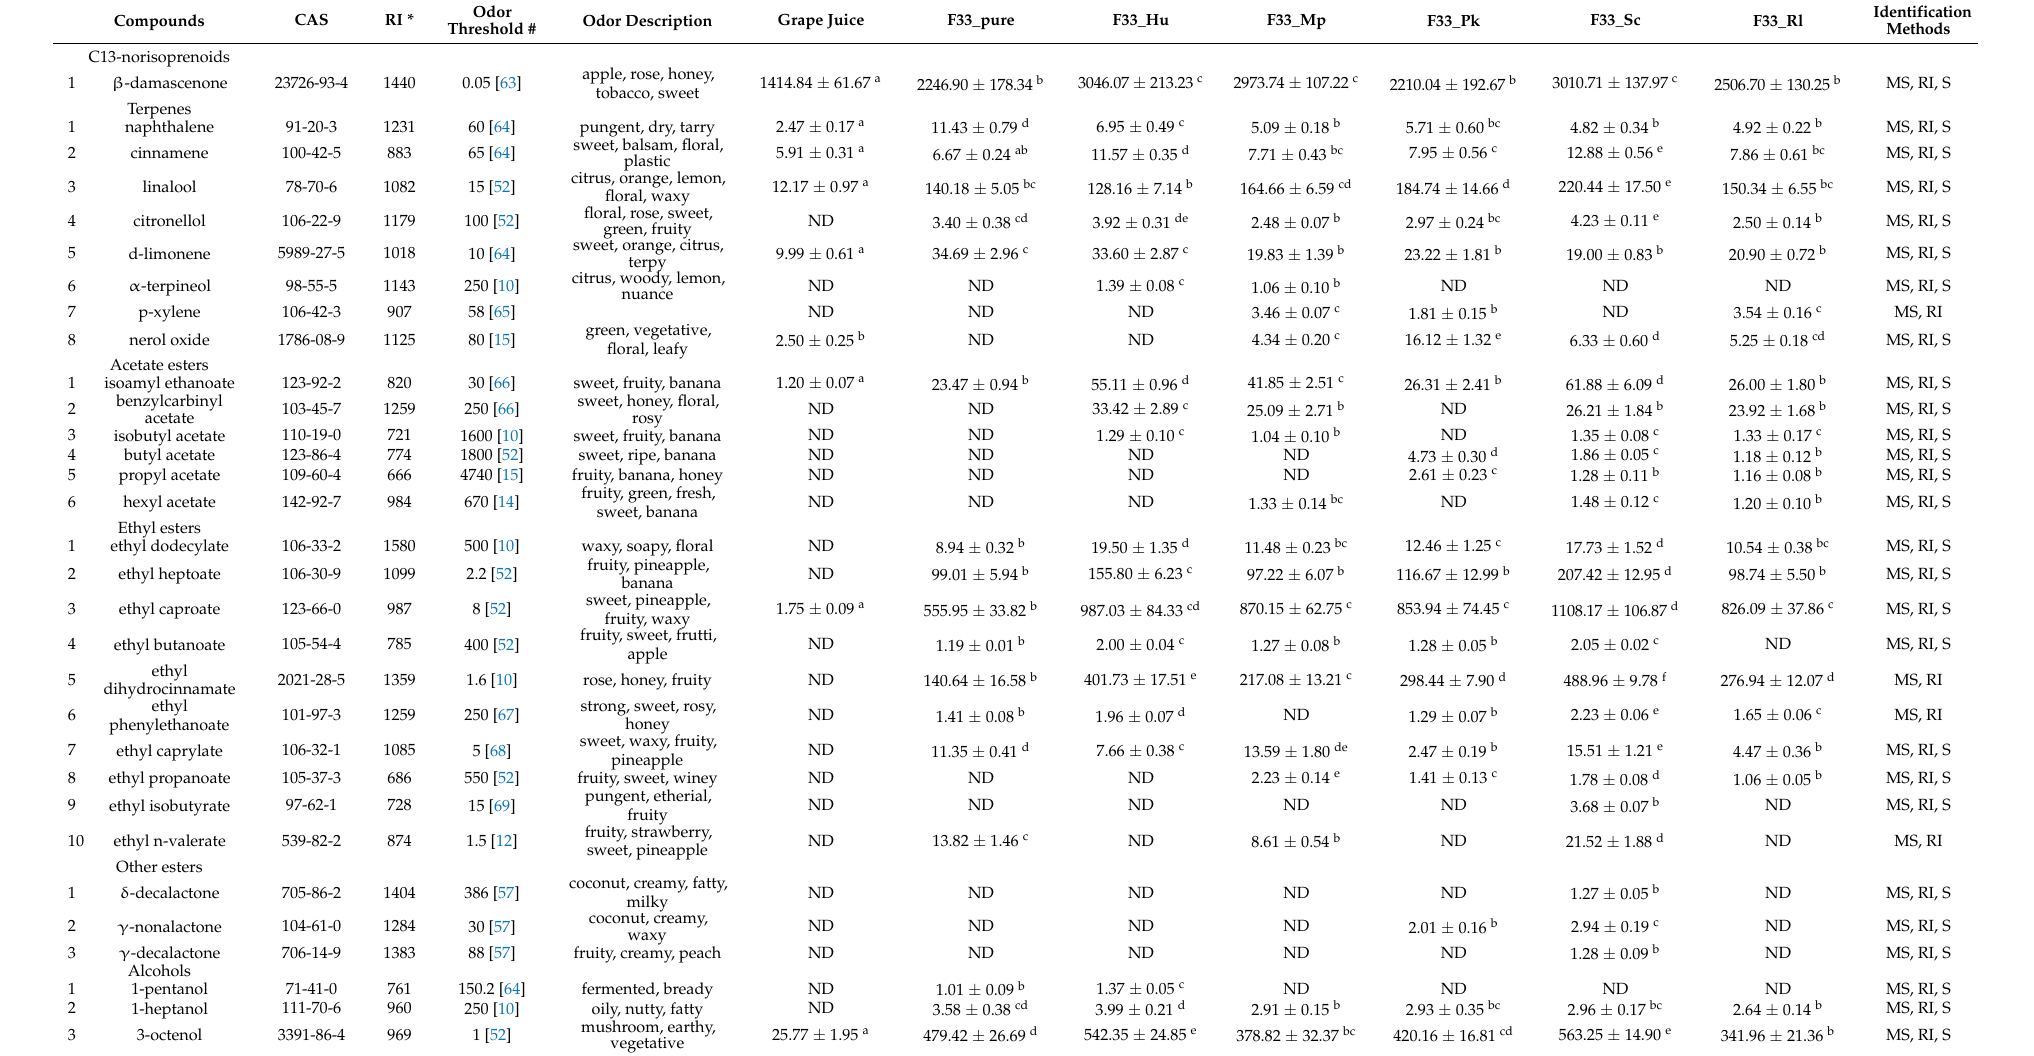
Table 4. Mean values of OAV for volatile compounds which presented OAV > 1 in Vidal icewine fermented with six fermentation